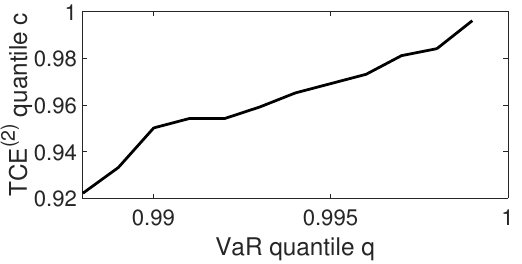
Figure 13. Extended TCE quantile, with m = 2, as a function of